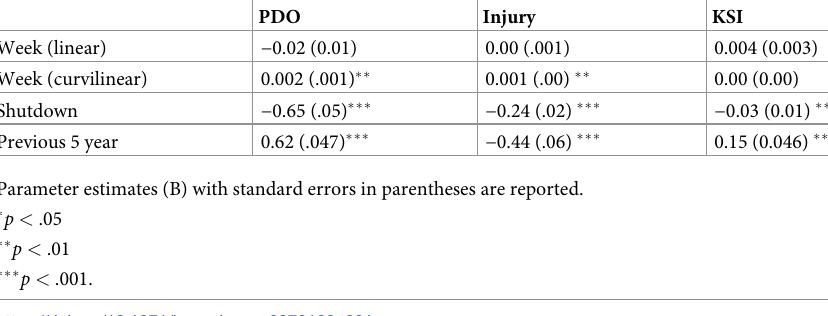
Table 1. Effects of week (linear and curvilinear) and shutdown on crashes per 10,000 residents. PDO